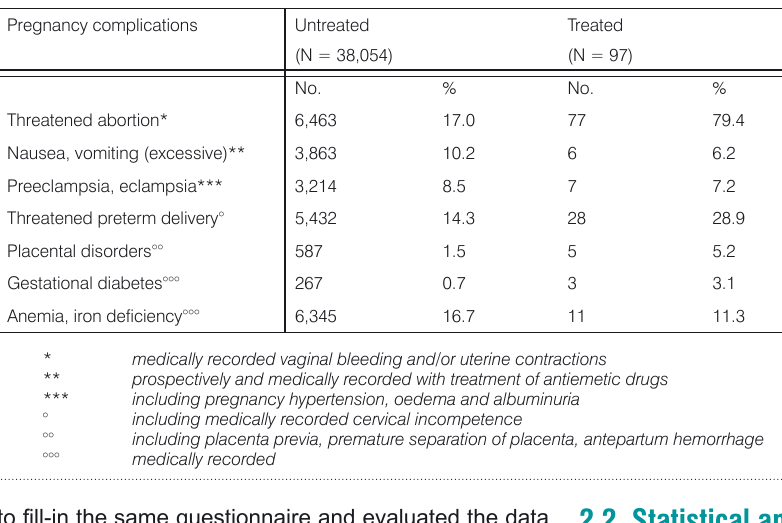
Table 2. Prevalence of pregnancy complications in pregnant women with or without HCG